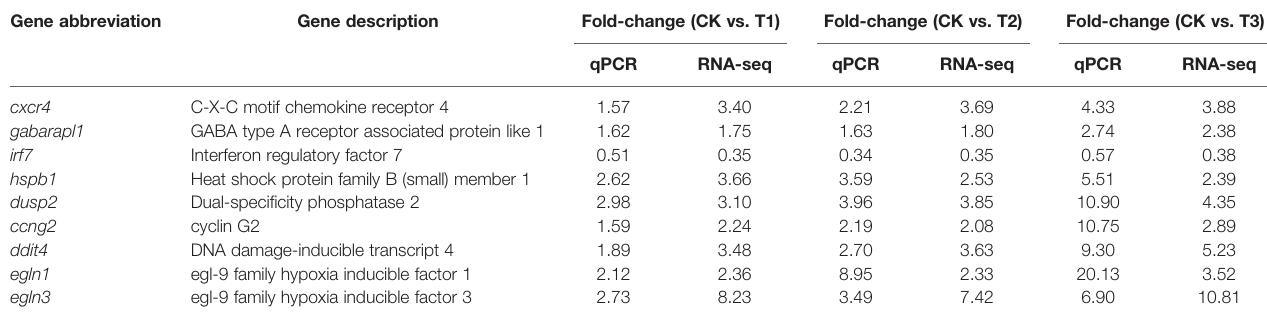
TABLE 4 | Comparisons of RNA-seq and RT-qPCR